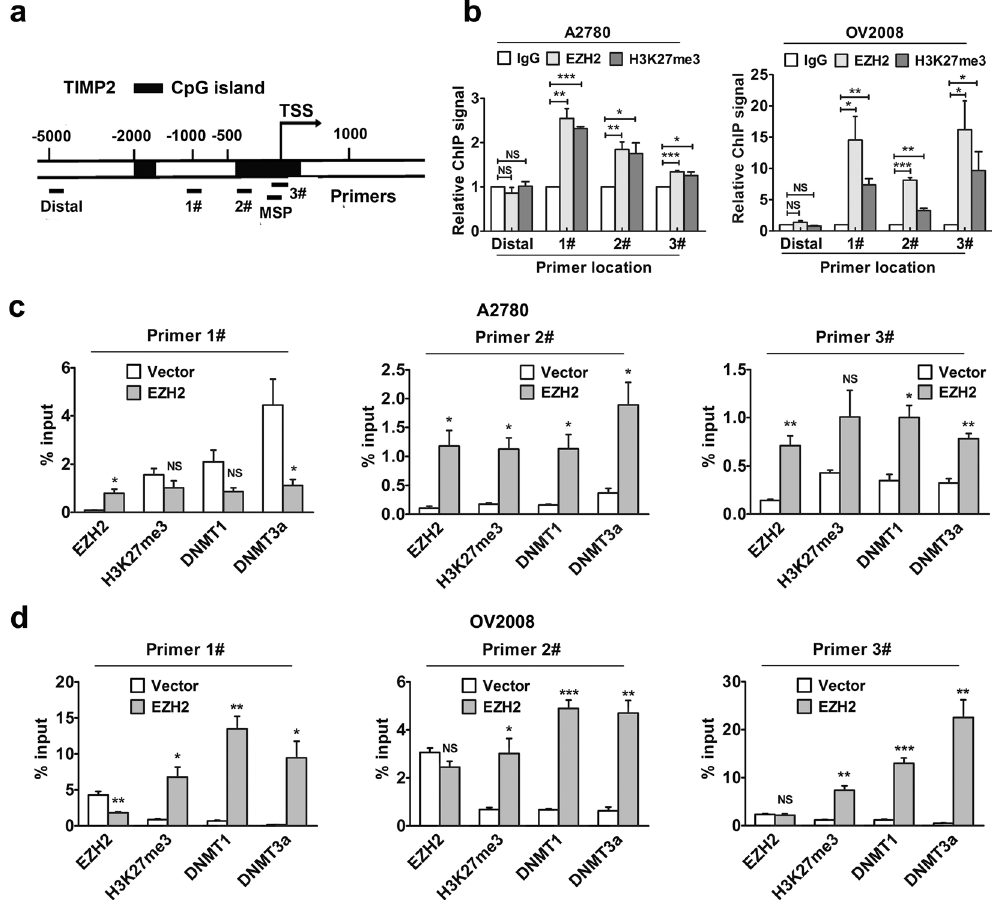
site. ( b ) qRT-PCR analysis of immunoprecipitated chromatin by EZH2 and H3K27me3 antibodies. IgG served as a negative control. ( c ) A2780 and ( d ) OV2008 cells were transfected with EZH2 overexpression plasmid or control followed by ChIP and qRT–PCR for the quantitative detection of EZH2, H3K27me3, DNMT1 and DNMT3a on the TIMP2 promoter. The results were normalized to the input. * P < 0.05; ** P < 0.01; *** P < 0.001. NS, not